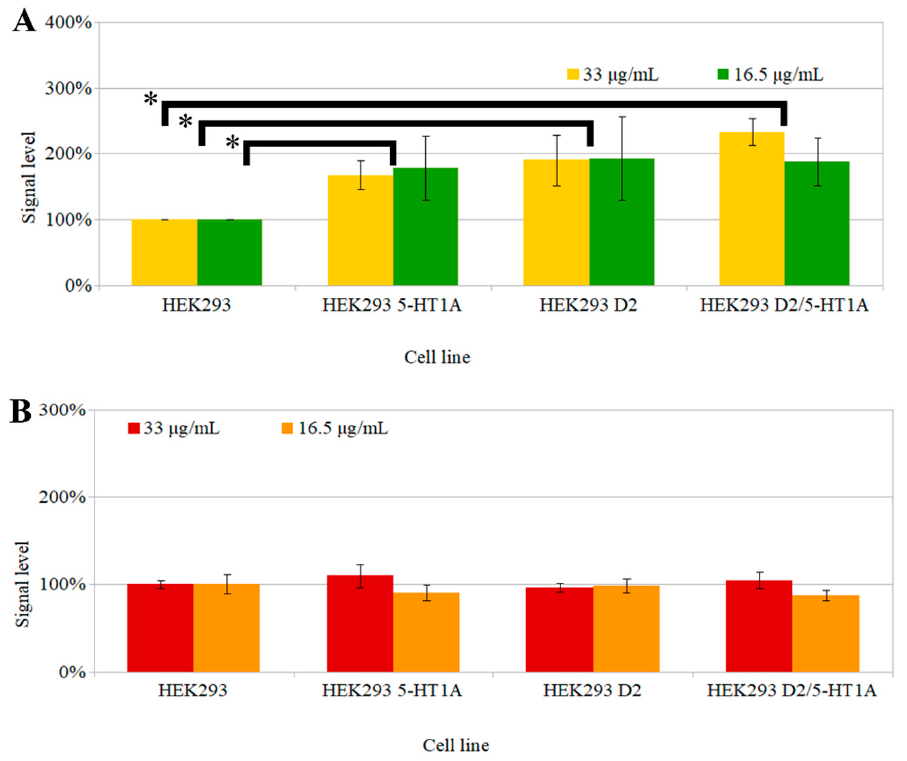
Figure 7. Homogeneous time-resolved fluorescence (HTRF) test results. On the X-axis are the cell lines used for the experiment. On the Y-axis is the signal, calculated by the ratio of the signal of the tested cells over the control (HEK293 cells). Two protein concentrations were used: 33 and 16.5 µ g/mL. Errors were estimated using the standard deviation calculated from three separate experiments. ( A ) cAMP (cyclic adenosine monophosphate) test; due to competitive character of the test, a higher signal indicates a lower amount of cAMP in cells; * p < 0.05 vs. HEK 293 cells (control); ( B ) IP1 (inositol monophosphate), no significant differences between the cell lines were observed.